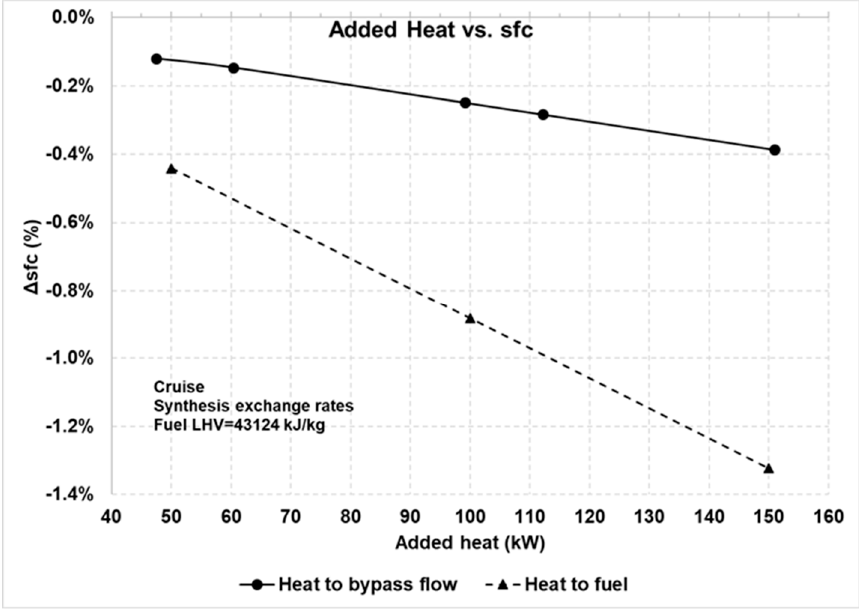
Figure 18. Added heat effect on SFC (synthesis exchange rates).